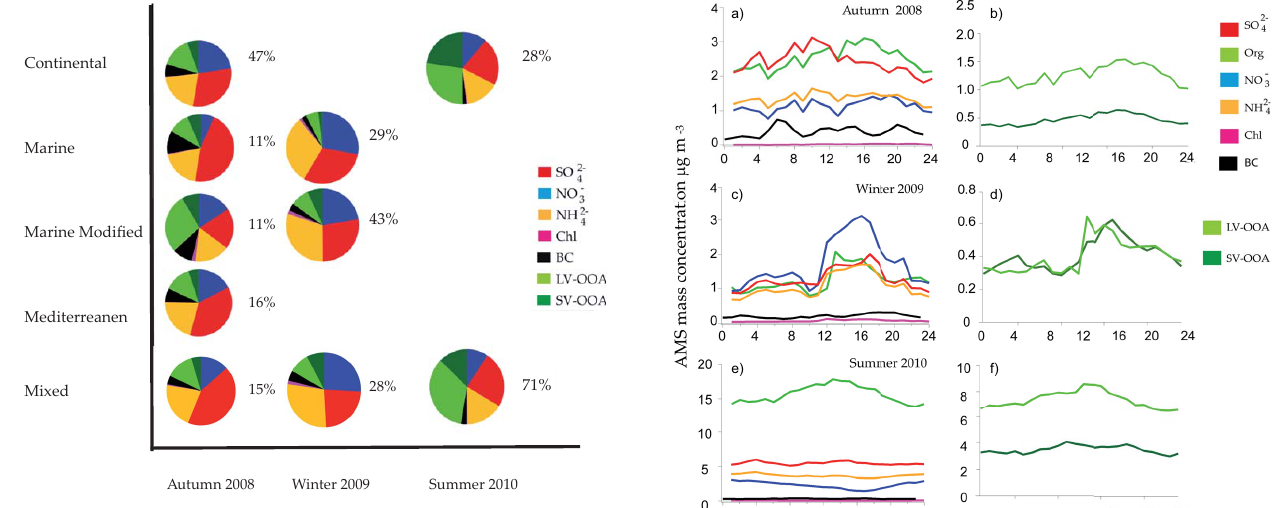
Fig. 5. Particle composition averaged over season and airmass type.